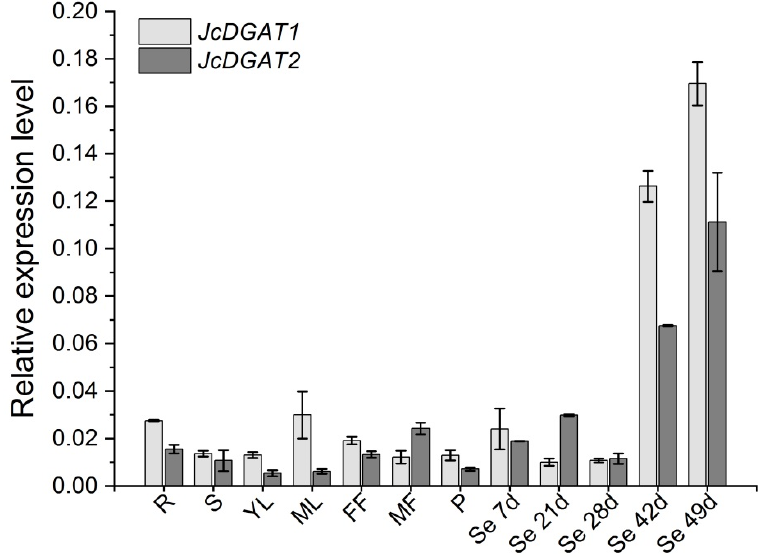
Figure 1. Expression patterns of JcDGAT1 and JcDGAT2 in J. curcas . The expression levels of JcDGAT1 and JcDGAT2 were analyzed in the roots (R), stems (S), young leaves (YL), mature leaves (ML), female flowers (FF), male flowers (MF), green pericarps (P), and seeds at 7, 21, 28, 42 and 49 days after pollination (DAP) (Se 7d, 21d, 28d, 42d and 49d, respectively). The qRT-PCR results were obtained from two independent biological replicates and three technical replicates. The levels were normalized using the amplified products of JcActin1 . The values are presented as the means ± standard deviations.